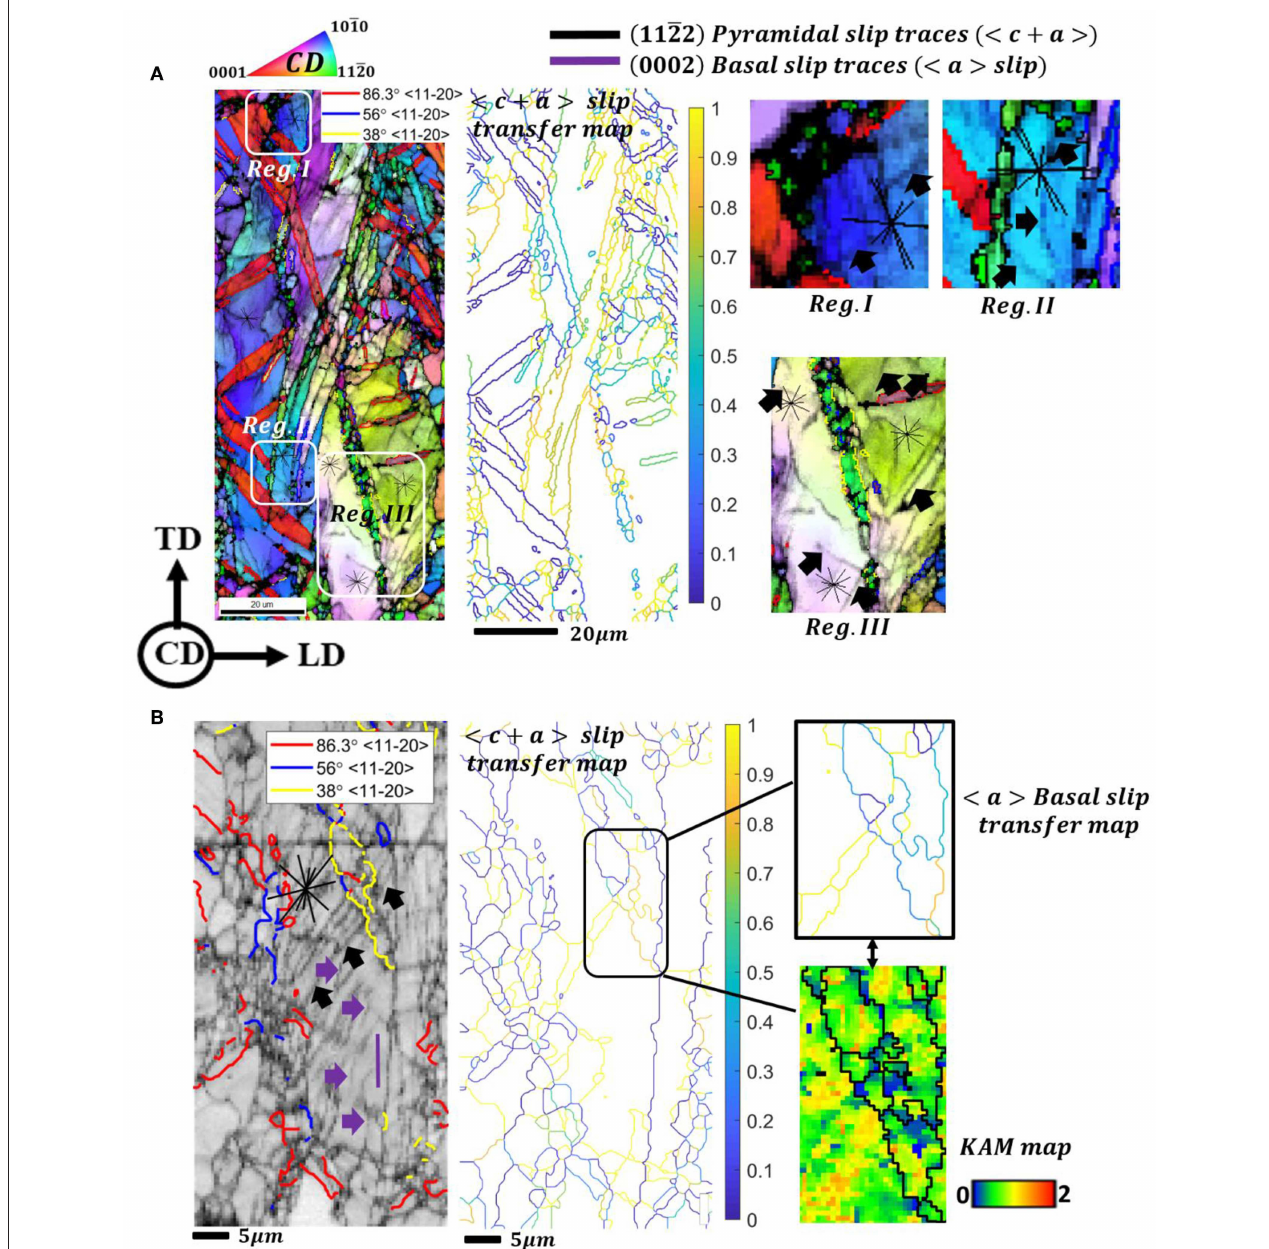
FIGURE 8 | Microstructural regions shown as inverse pole figure maps and grain boundary slip transmission map, (A,B) in the as-deformed ZEK110 alloy showing profuse (1122) < 1123 > pyramidal slip (indicated by black slip traces) and secondary (0001) < 1120 > basal slip (shown in purple slip traces) both inside the parent as well as twinned areas. Regions in (A) are magnified, indicating a good agreement of the observed slip traces in matrix and twinned regions with (1122) < 1123 > pyramidal slip. The grain-boundary slip transfer maps in (A,B) correspond to (1122) < 1123 > pyramidal slip. The slip transmission map on the right hand side in (B) , describes the favorability of transfer of (0001) < 1120 > basal dislocations across the twin/grain boundaries in the region of interest highlighted by the black window. The bottom right image in (B) depicts the kernel average misorientation (KAM) map of the area of interest.